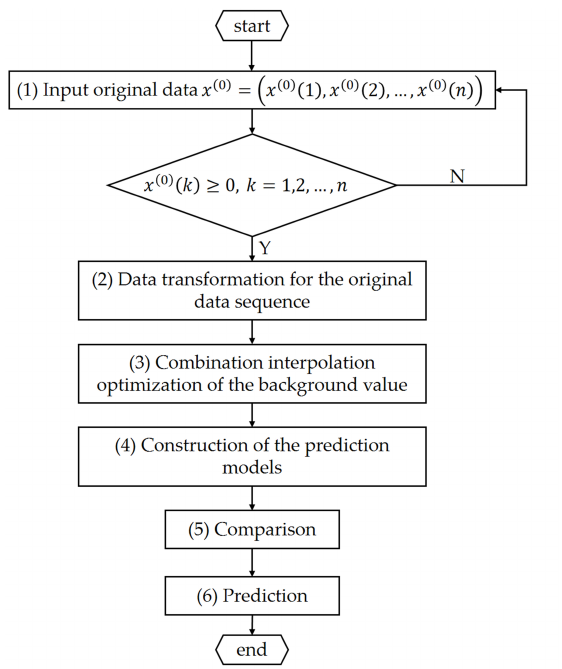
Figure 1. The flowchart of